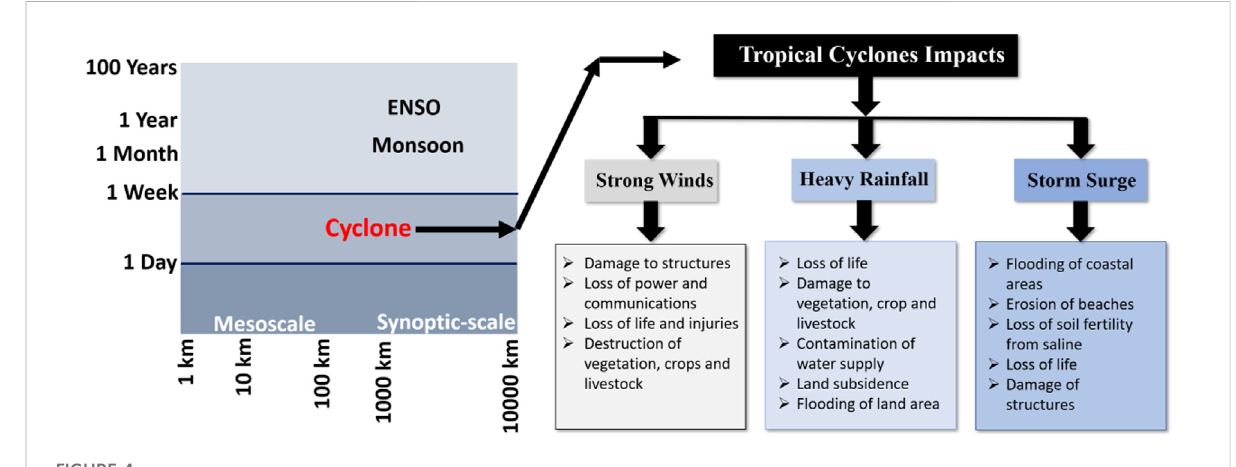
FIGURE 4 Various characteristics of a TC those can make severe impacts on lives and